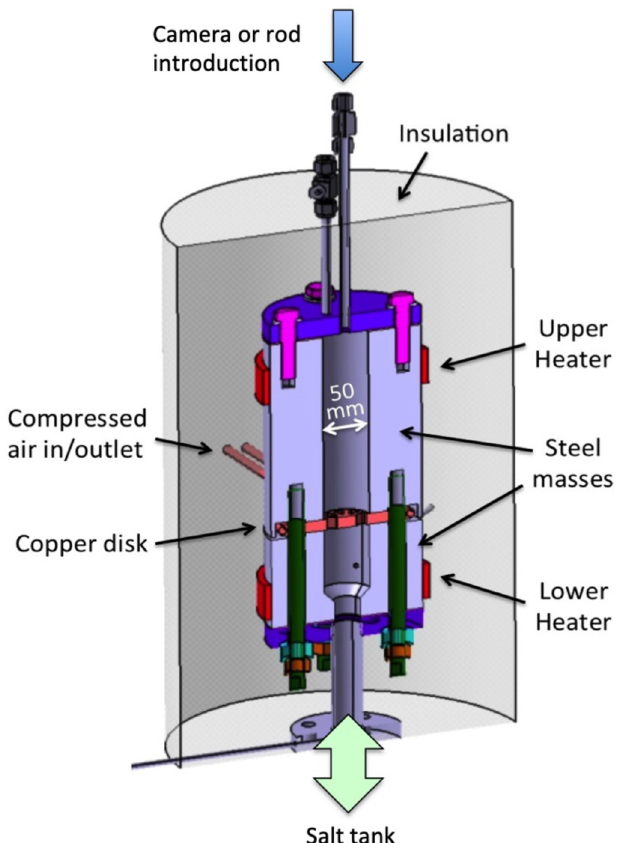
Fig. 8. Layout of the cold plug device tested in SWATH